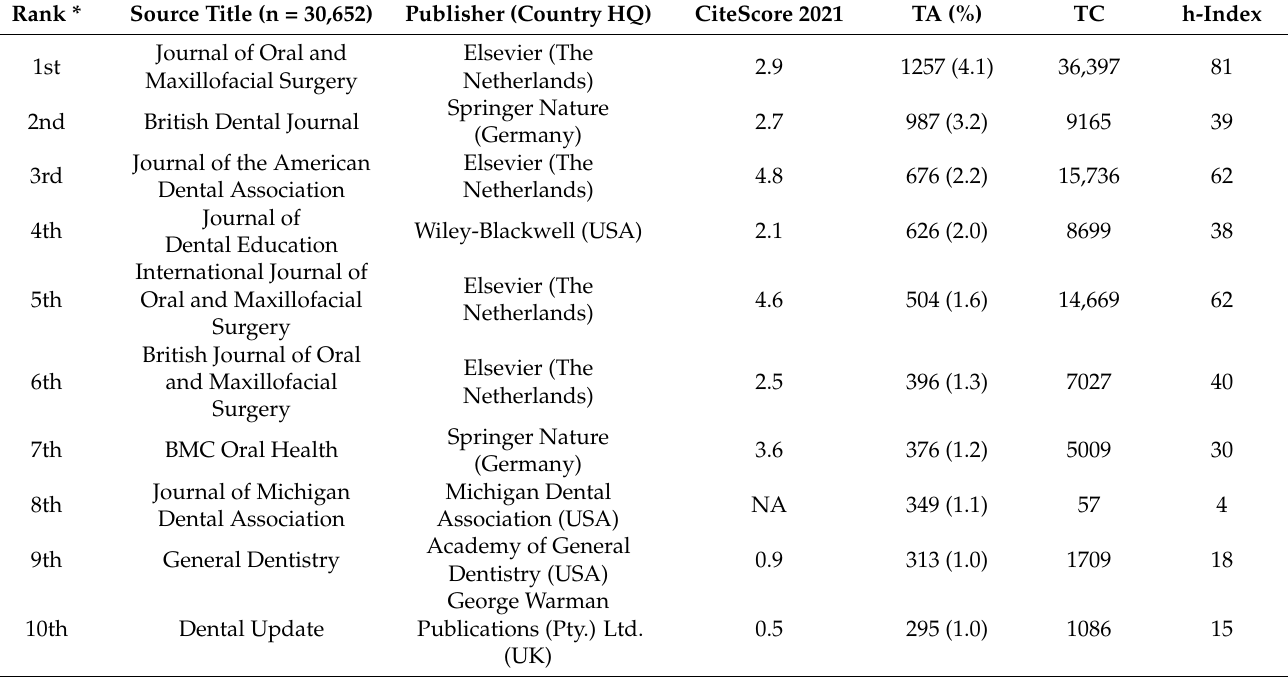
Table 7. Top ten journals publishing articles on dentists.